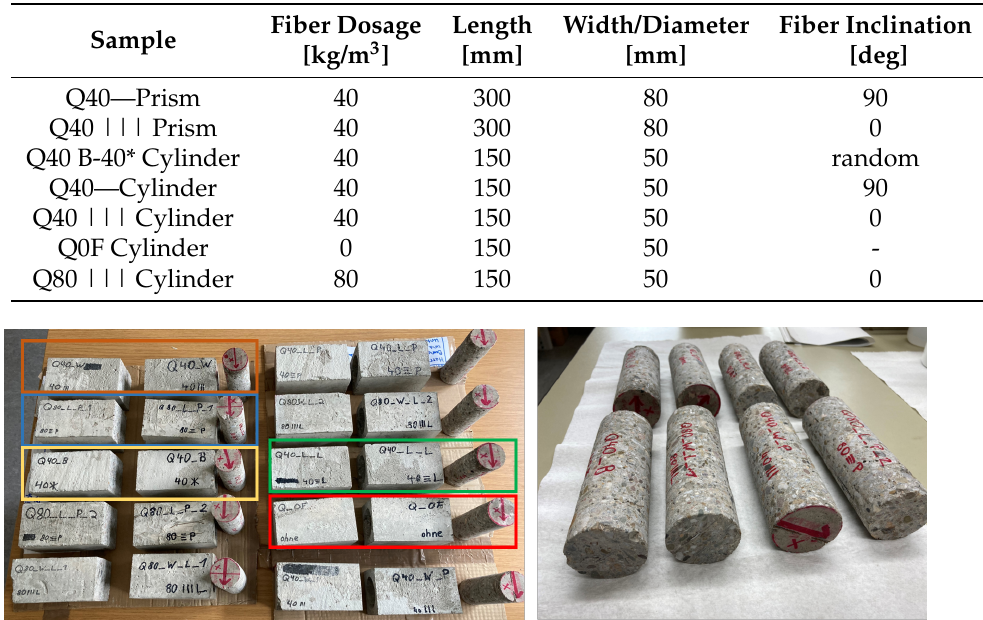
Table 1. Summary of the SFRC samples used in this study, their geometric properties, fiber dosages and fiber inclinations relatie to the longitudinal sample axis. Cylinders are sub-samples of prisms, as shown in Figure 3.